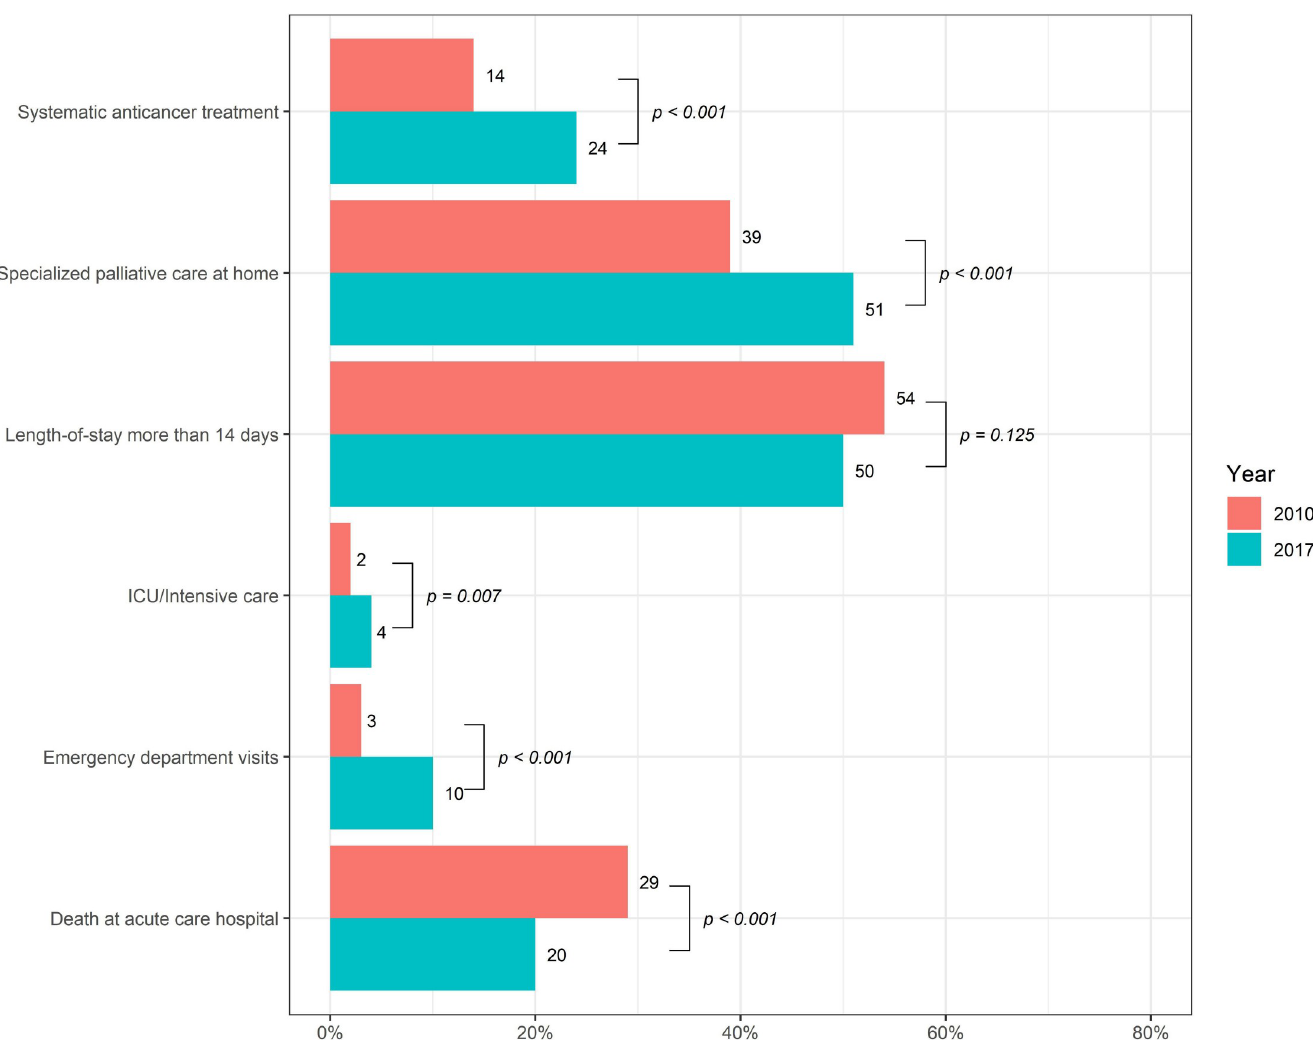
Fig 1. Trends in intensity of End-of-life care between the years 2010 and